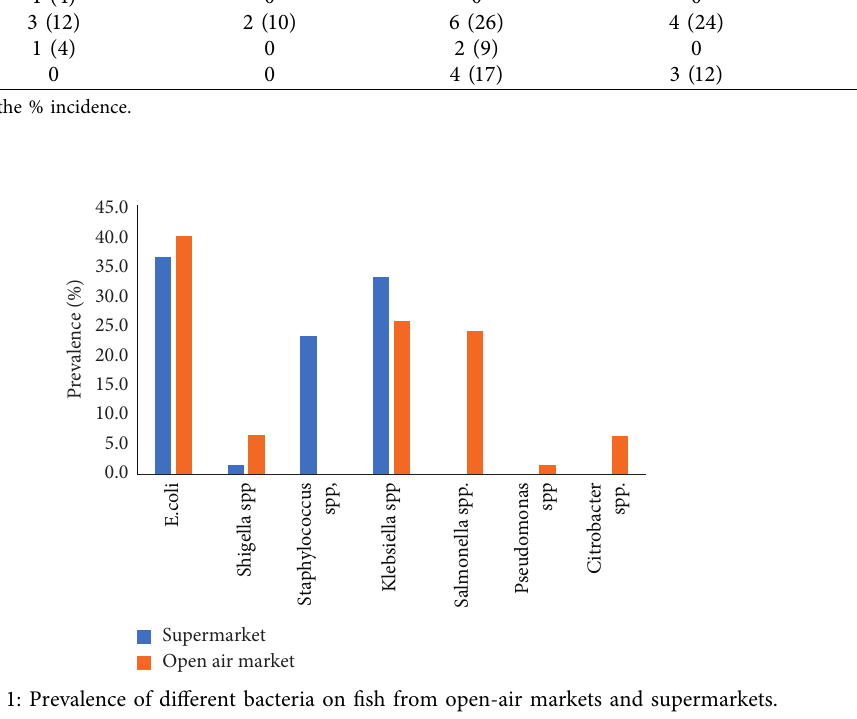
Figure 1: Prevalence of different bacteria on fish from open-air markets and supermarkets.